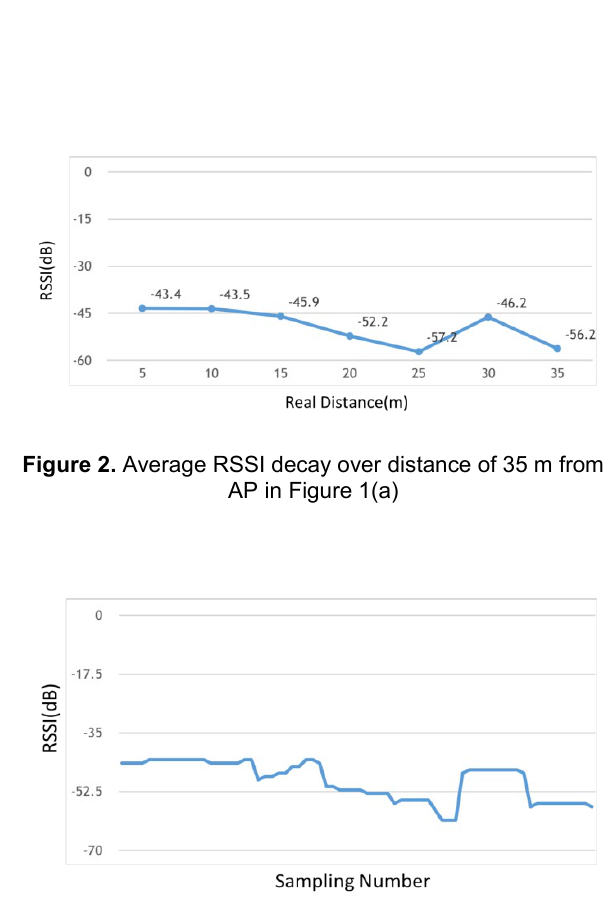
Figure 3. RSSI variation over 10 samples collected at each observation point in Figure 1(a)